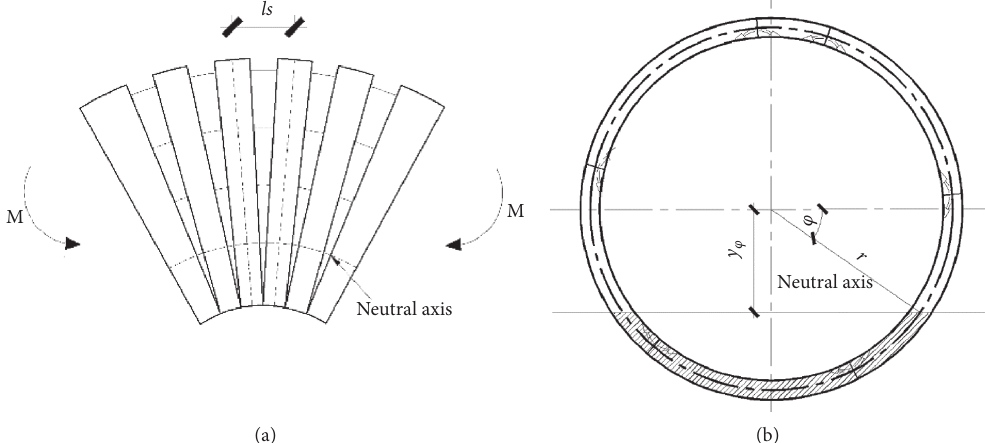
Figure 1: Schematic diagram of shield lining bending deformation. (a) Deformation of segments joints system subjected to bending moment. (b) Cross section of the deformation of lining.